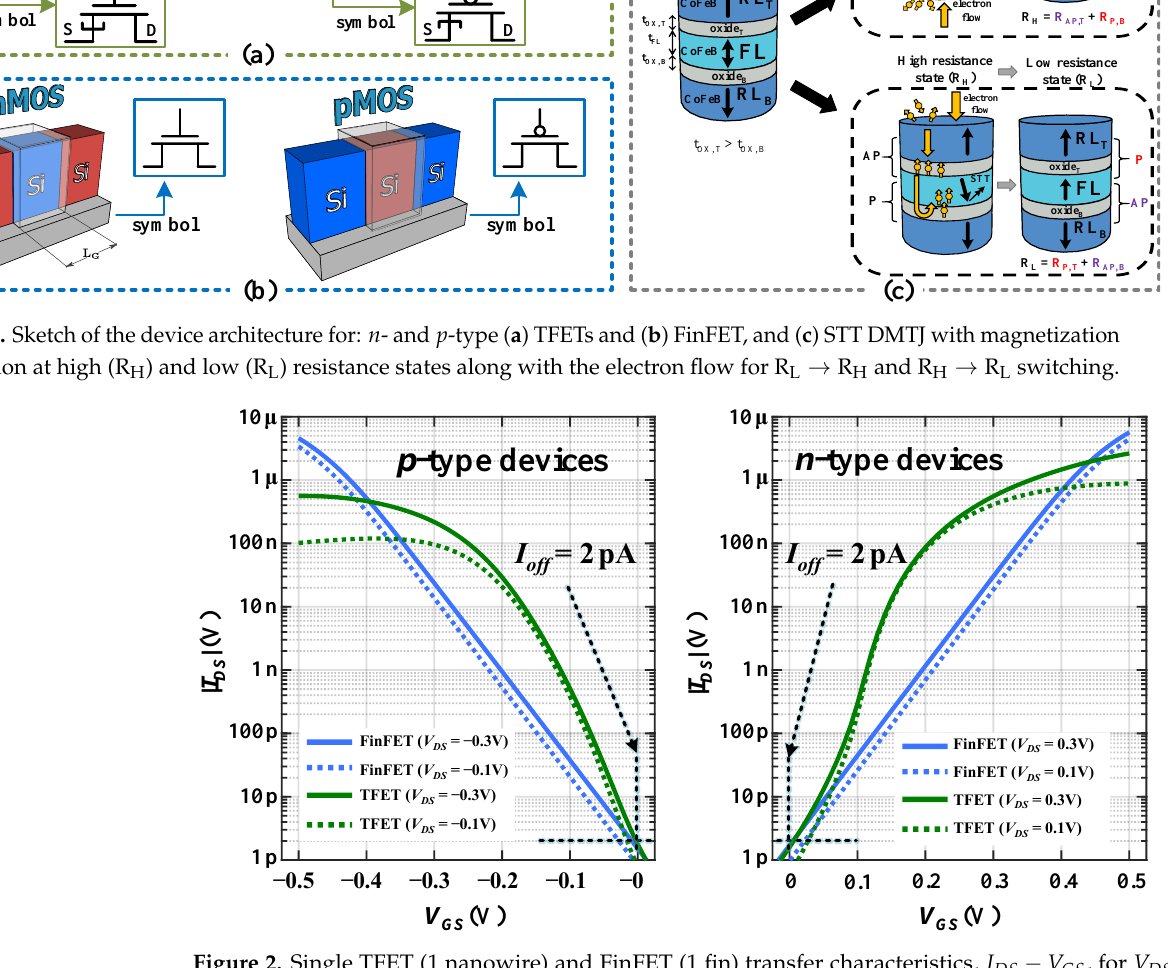
Figure 2. Single TFET (1 nanowire) and FinFET (1 fin) transfer characteristics, I DS − V GS , for V DS of 0.1V and 0.3V redrawn from [17]. TFET and FinFET characteristics are aligned at the same I of f ≈ 2pA at V DS =